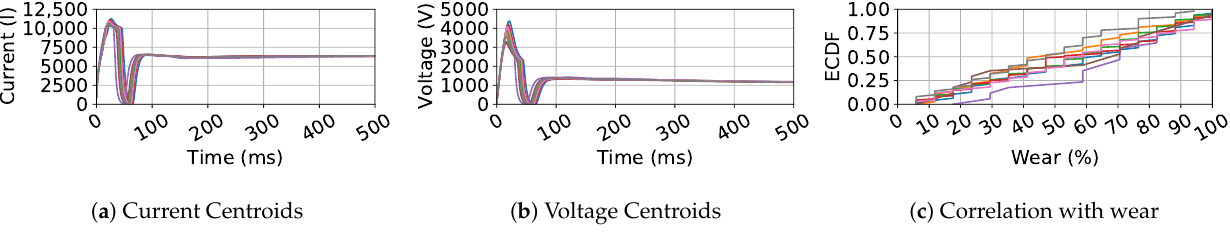
Figure 15. Clusters representation wp Working Station 2 Clamp 1, Whole Time-Series Data Selection.